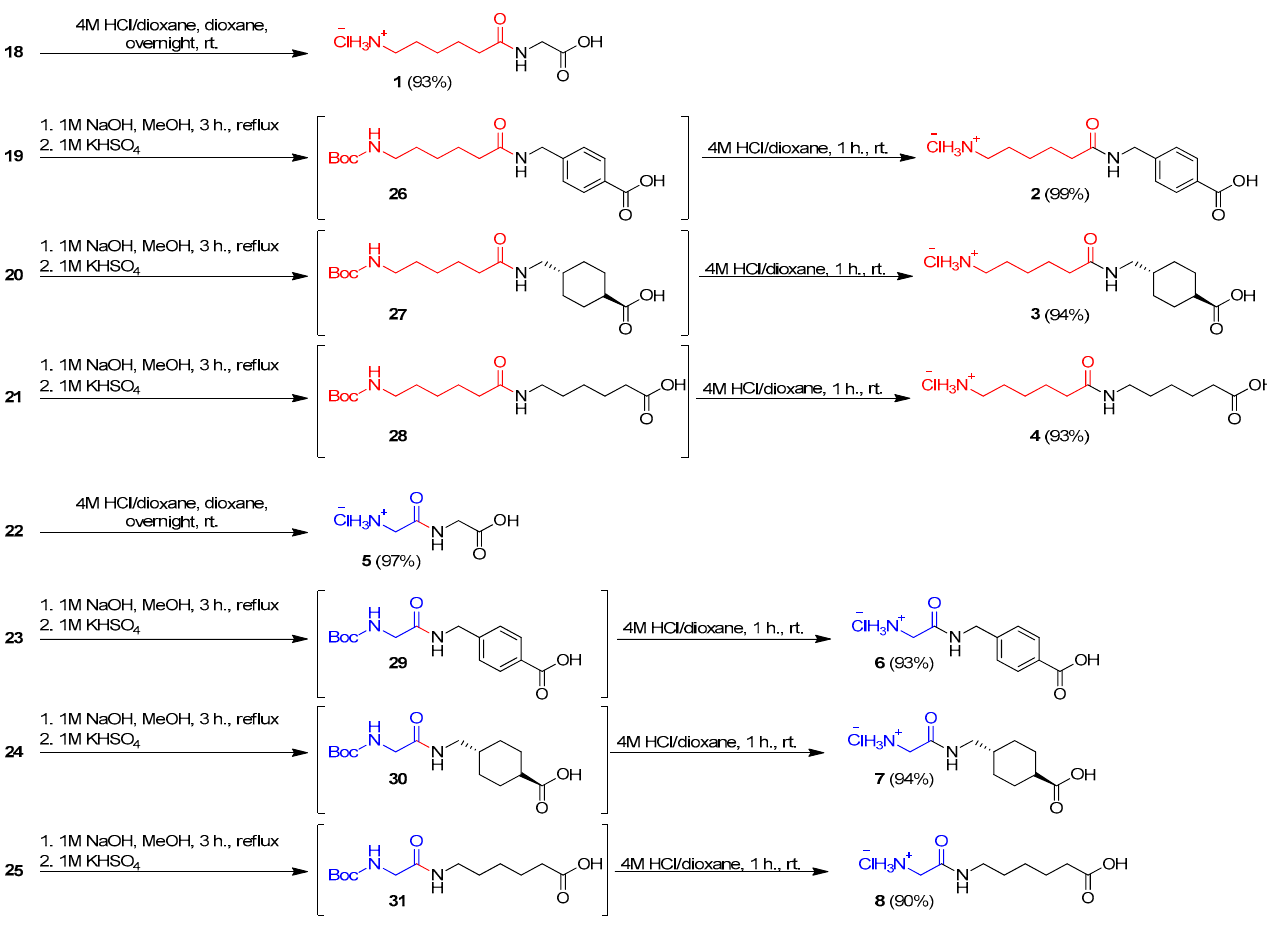
Figure 6. Synthesis of hydrochlorides of amides 1 – 8.